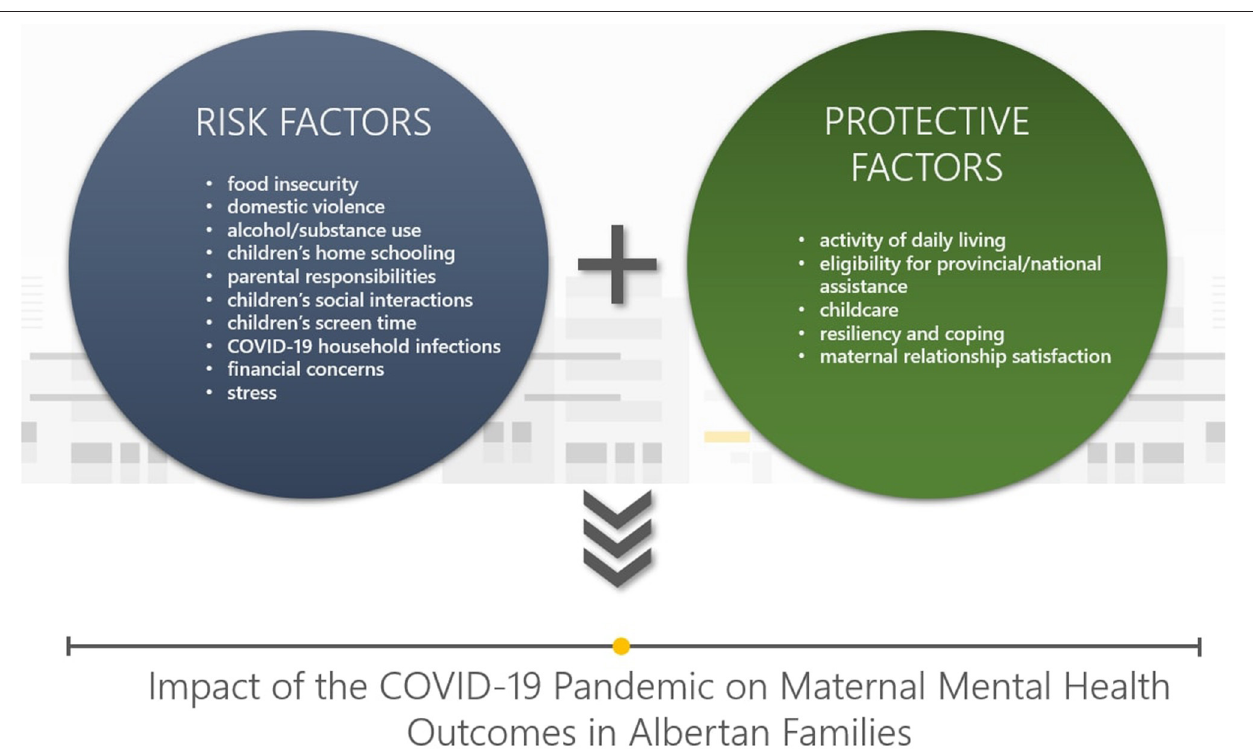
FIGURE 1 | Risk and protective factors that influence impacts of the COVID-19 pandemic on maternal mental health in Albertan